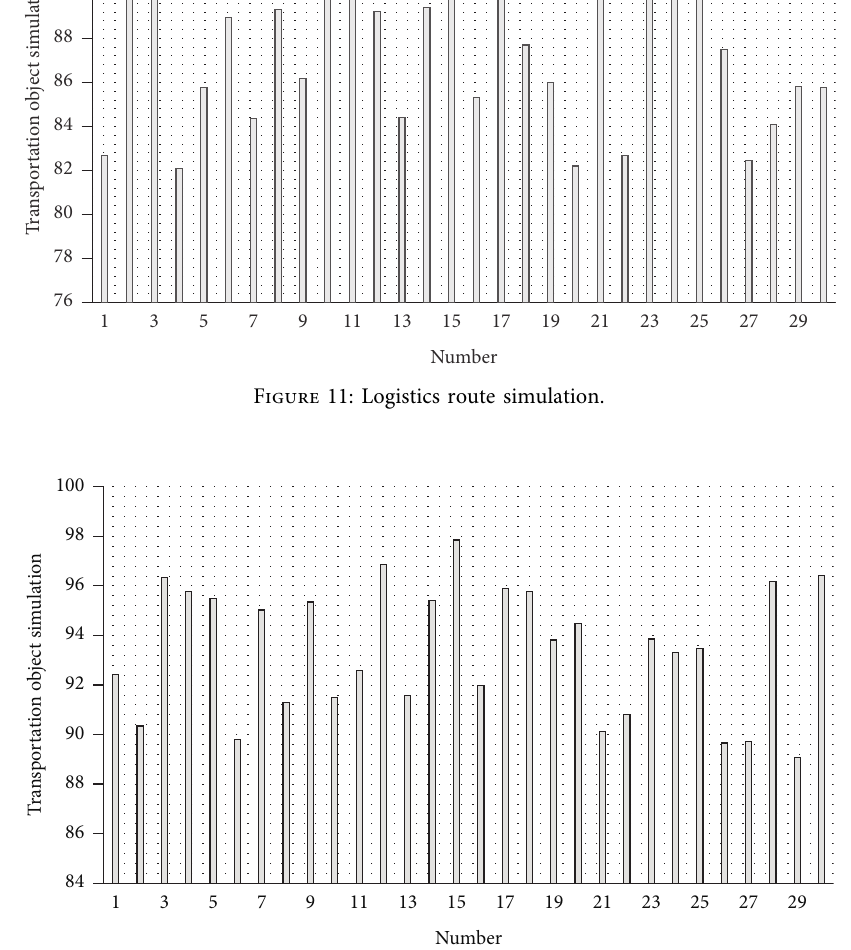
Figure 12: Information transfer